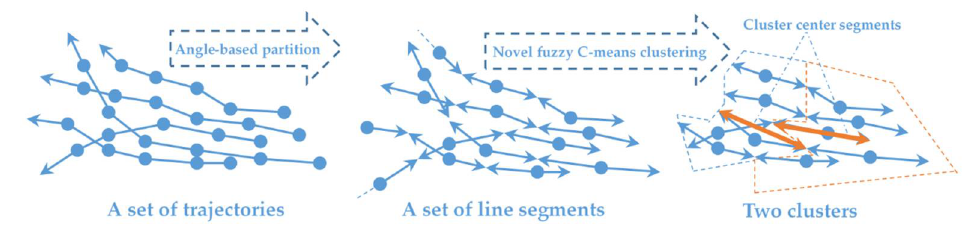
Figure 5. Illustration of trajectory clustering.